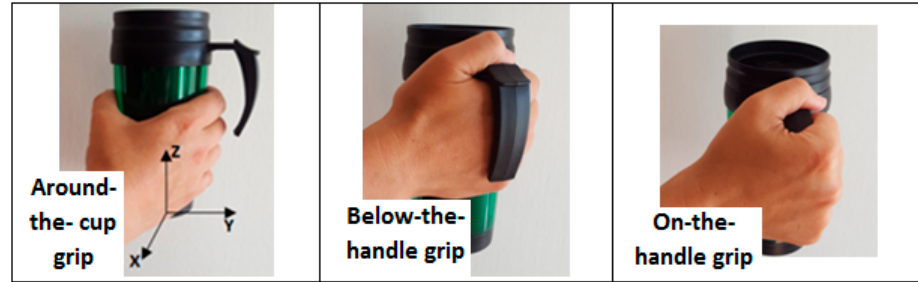
Figure 1. Cup with Axis Orientation of Measured Acceleration and Varied Cup-Grip Types.